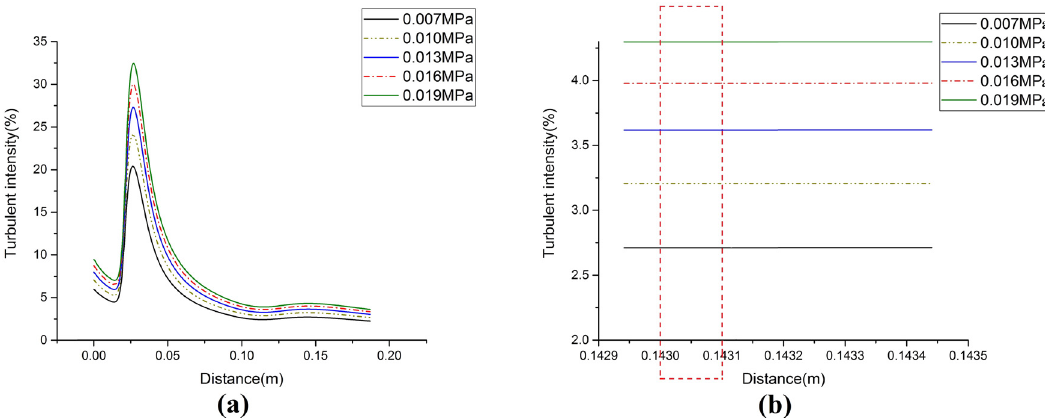
Figure 7: Centerline turbulence intensities under di ff erent air pressures: ( a ) research distance is [ 0, 0.187 m ] , ( b ) research distance is the e ff ective stretch distance.